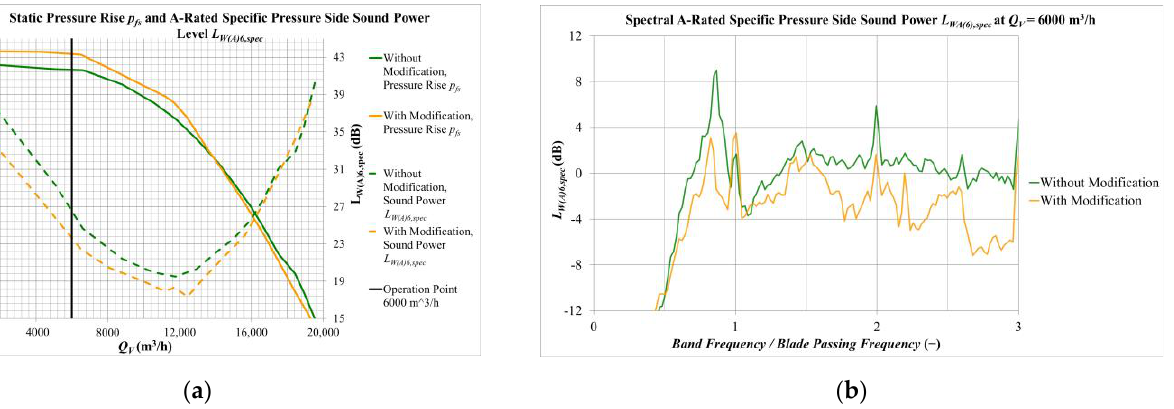
Figure 10. Experimental evaluation of the impact of the downstream modification in A-weighted pressure side specific sound power L WA 6 for the configuration of Figure 9: ( a ) sound power sum; ( b ) spectral